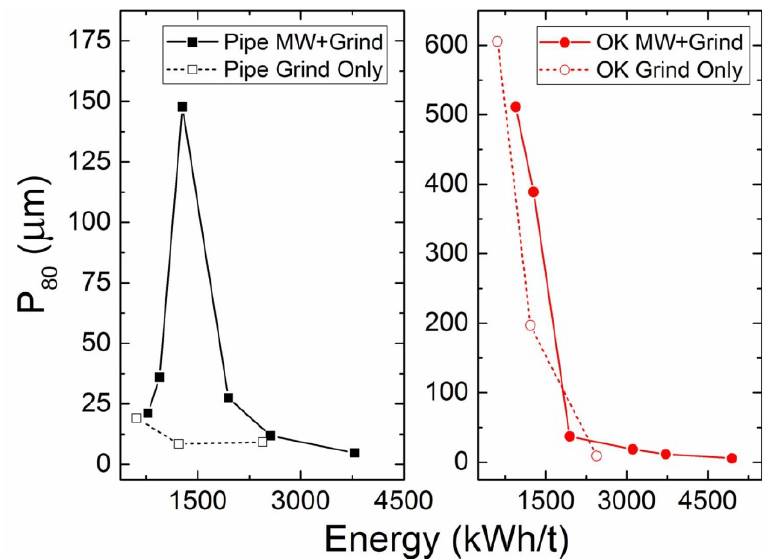
Figure 15. Sample P 80 versus energy expended for Pipe and OK ore microwave pretreated and ground for various times (MW + Grind), or ground only for various lengths of time (Grind Only) [48].